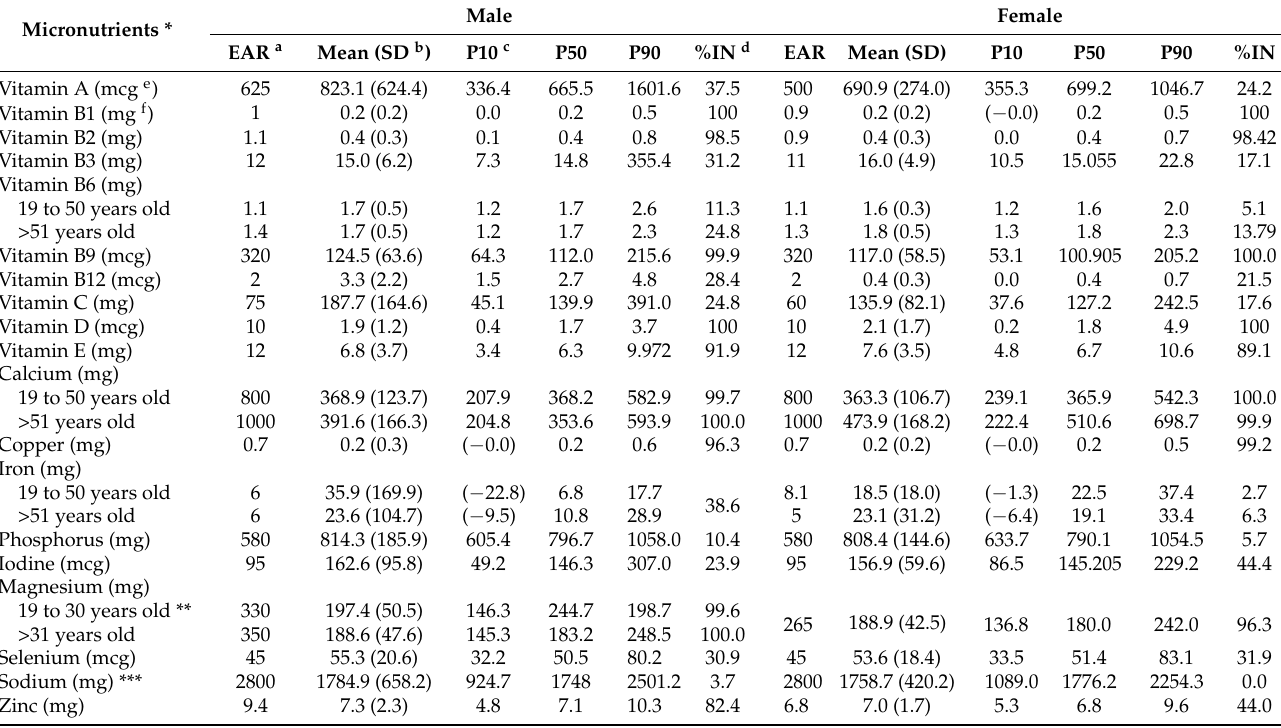
Table 2. Daily nutritional recommendations, micronutrient intake, and prevalence of inadequate micronutrient intake (% IN), by sex and age group, in patients with